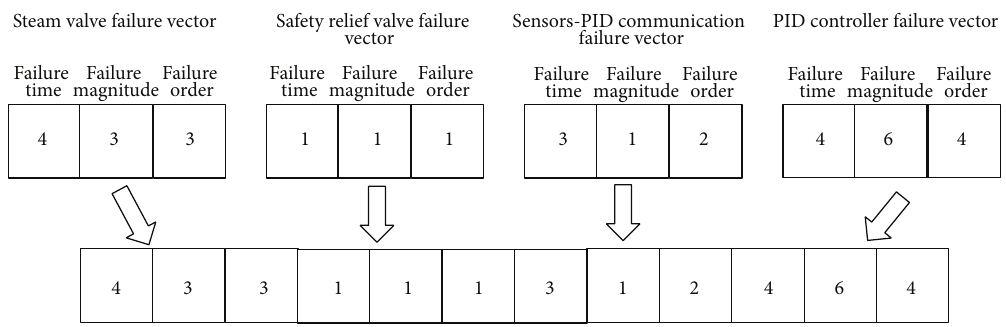
Figure 5: Sequence vector representing a scenario. Table 2: System